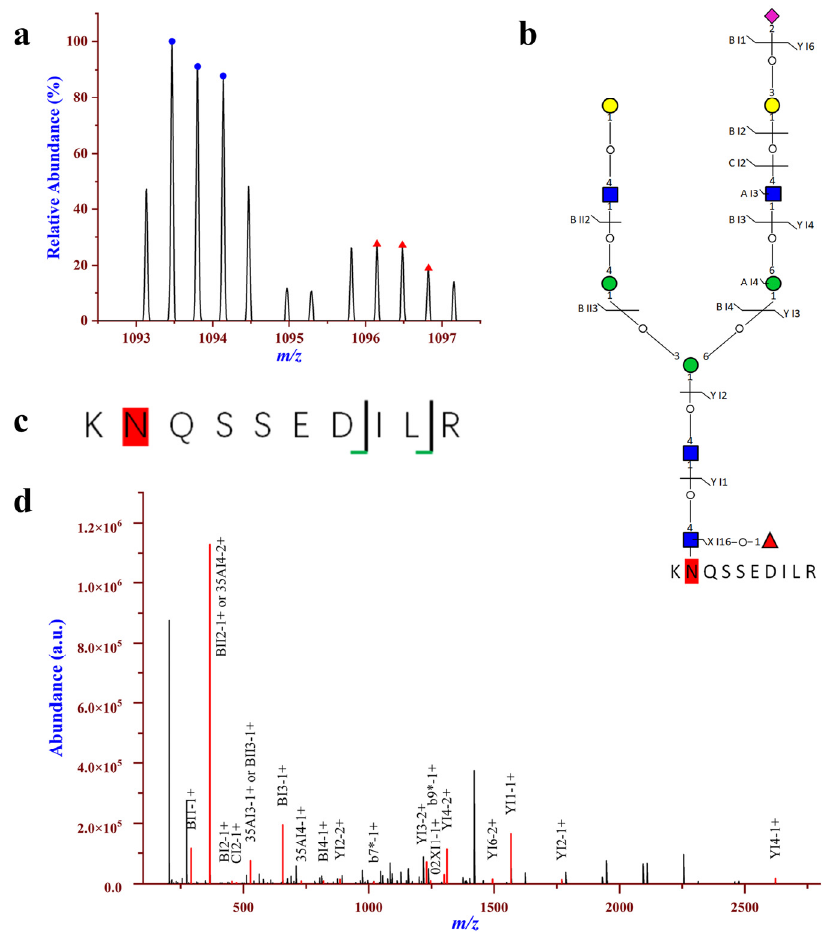
Figure 5. Down-regulation of intact N-glycopeptide KNQSSEDILR_N4H5F1S1 in urinary EVs from patients with HCC relative to NC; the N-glycosite is N478 on Apoptosis-stimulating of p53 protein 2 (ASPP2_HUMAN, Q13625). ( a ) Paired precursor ions. ( b , c ) N-glycan and peptide backbone graphical fragmentation maps annotated with the matched fragment ions. ( d ) The MS/MS spectrum with the matched fragment ions.